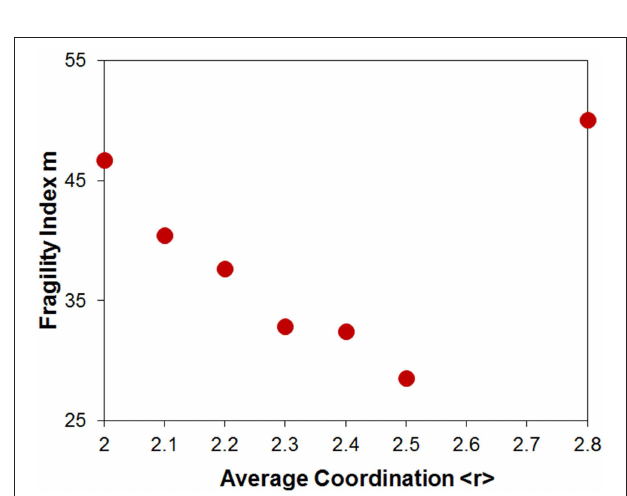
FIGURE 7 | Fragility Index m of glasses from the As-Se system as a function of average coordination < r > . Labels identify the dimensionality character of the network. Data from Yang et al. (2012).